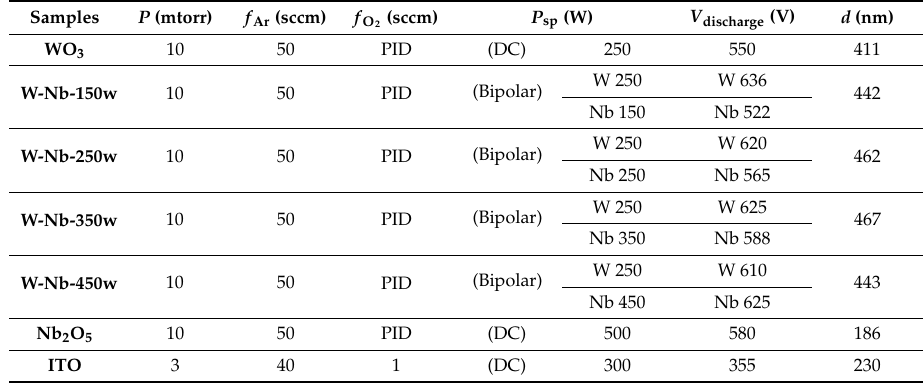
; sputtering power, P sp 2